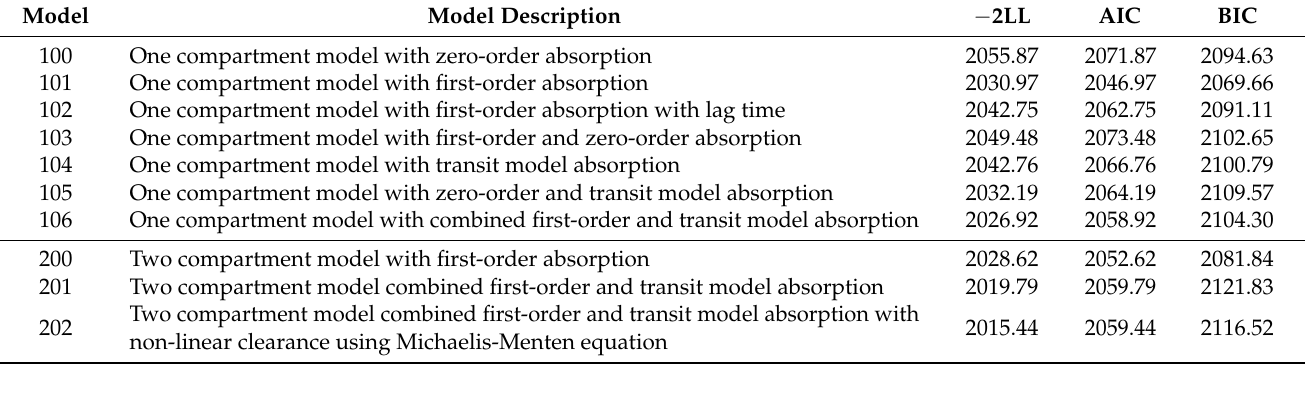
Table 2. Pharmacokinetics (PK) model development process for lidocaine-incorporated hyaluronic acid injection (LHA) administration groups.